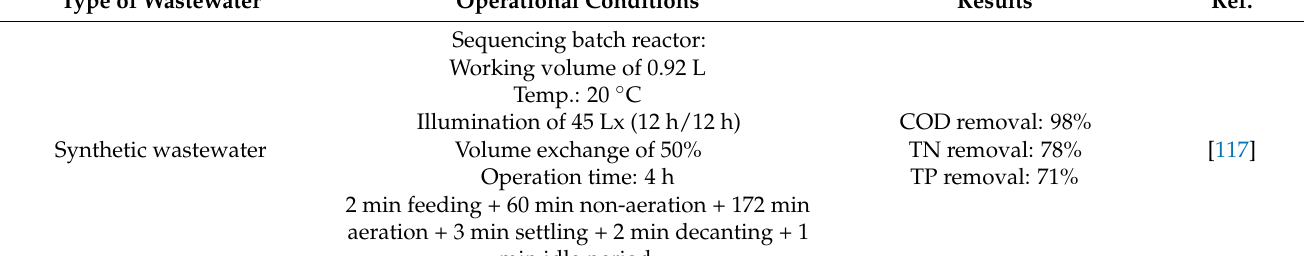
Table 6. Example applications of microalgal-bacterial granular consortia in wastewater treatment. Type of Wastewater Operational Conditions Results